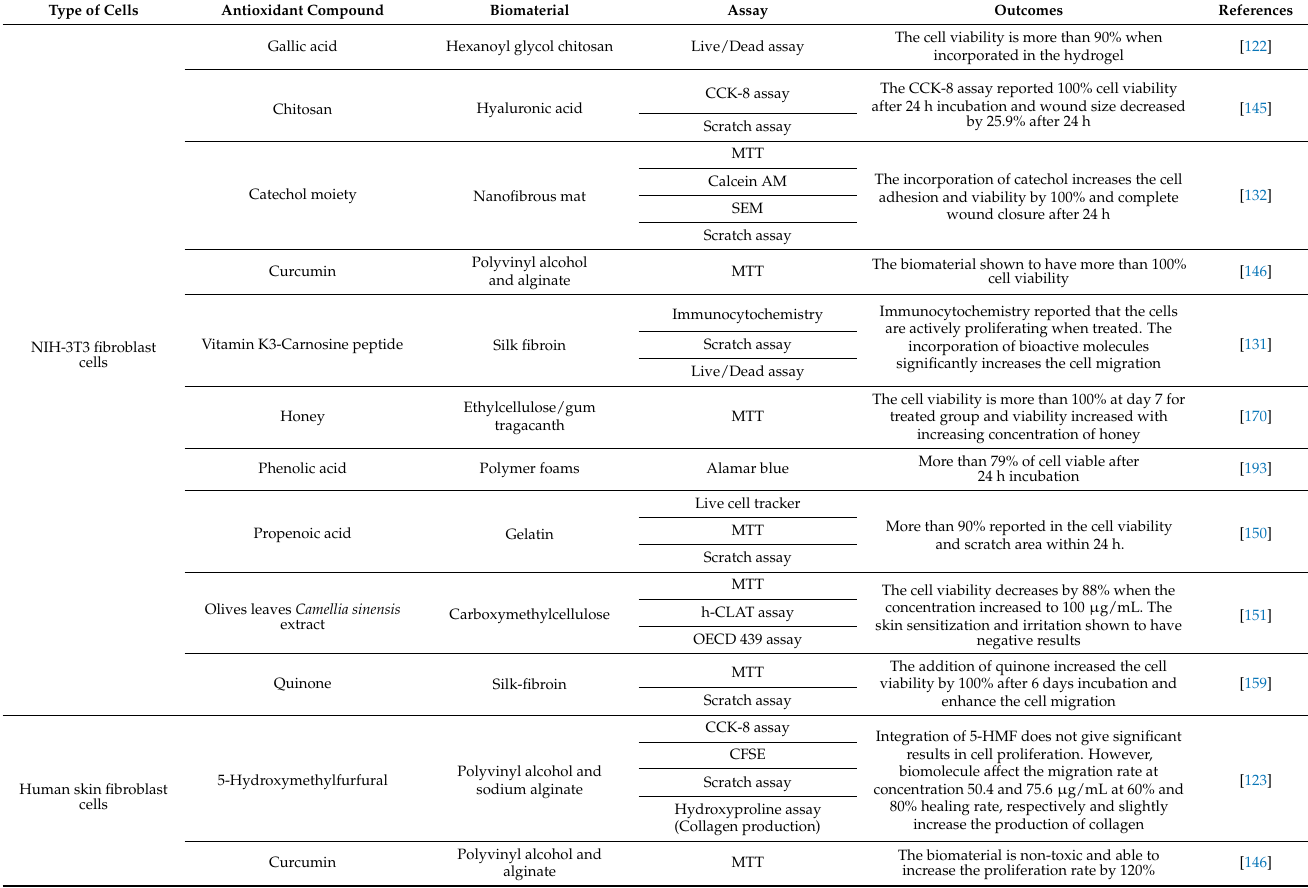
Table 4. The in vitro studies of antioxidant